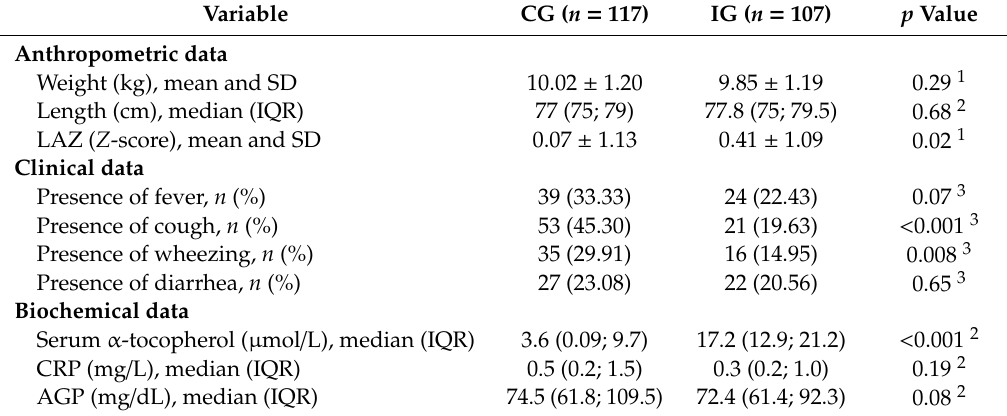
Table 2. Anthropometric, clinical, and biochemical data on participating children at the end of the ENFAC study (Goi â nia, 2013; n =